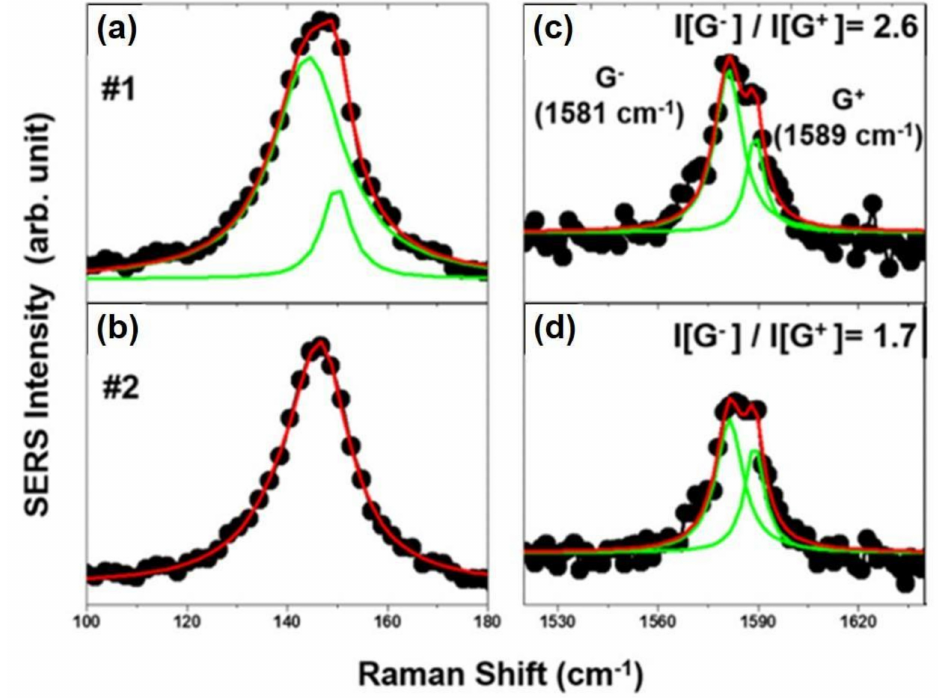
Figure 9. ( a )/( c ) and ( b )/( d ) showed the corresponding Raman peak shapes of RBLM and G mode for #1 and #2 positions exhibited in Figure 8b, respectively. Immensely increased G peak could be decoupled into G − and G + with each intensity ratio written at the upper-right locations in ( c , d ). The calculated higher I(G − )/I(G+) values were corroborated with the higher RBLM intensity and higher asymmetric RBLM peak shape. Reprinted with permission from ref.